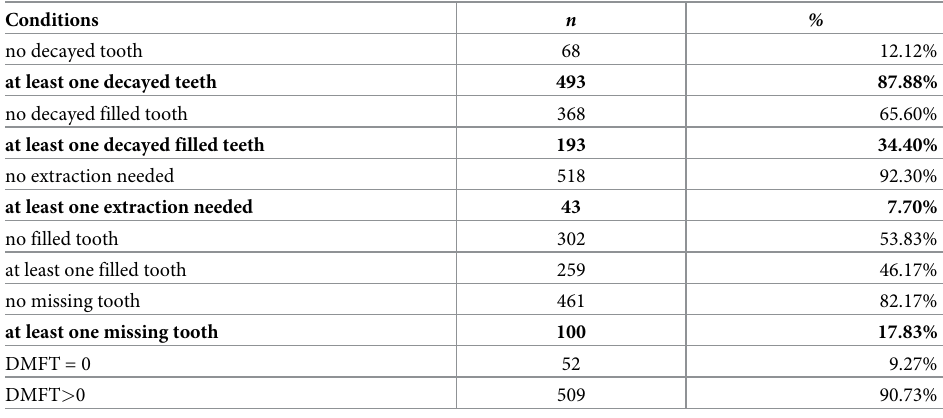
Table 6. DMFT distribution � .